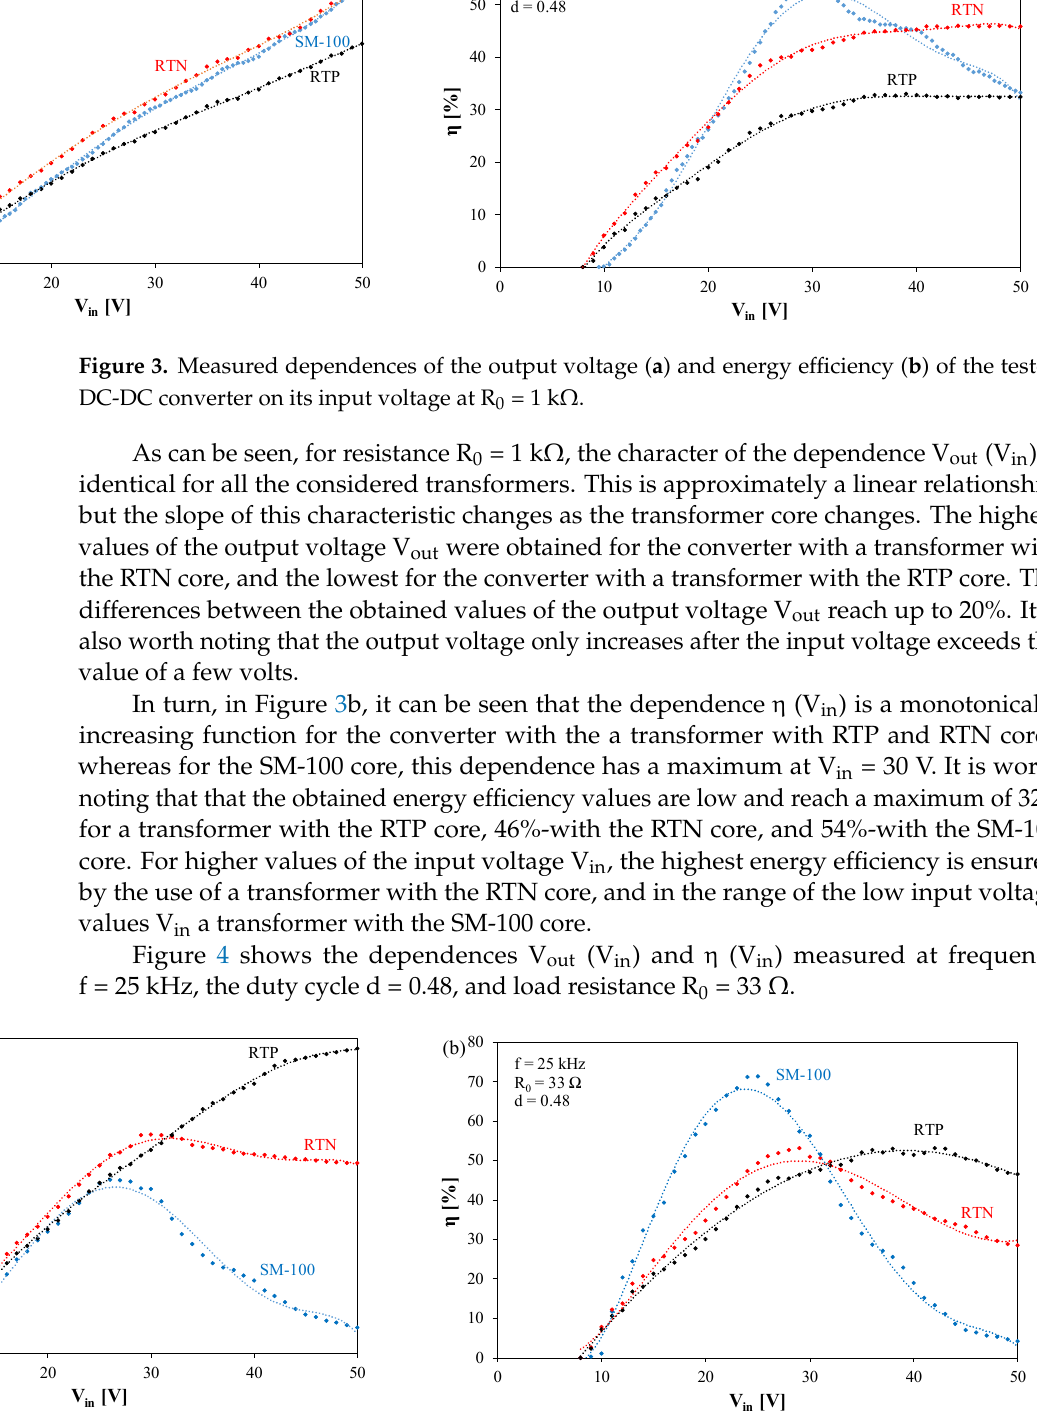
Figure 4. Measured dependences of the output voltage ( a ) and energy efficiency ( b ) of the tested DC-DC converter on its input voltage at R 0 = 33 Ω .